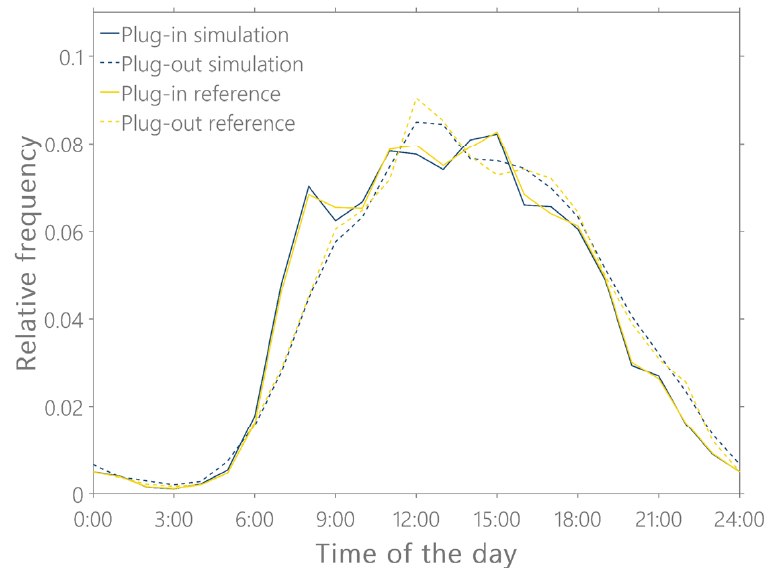
Figure 17. Relative frequency for plug-in and plug-off during a day.